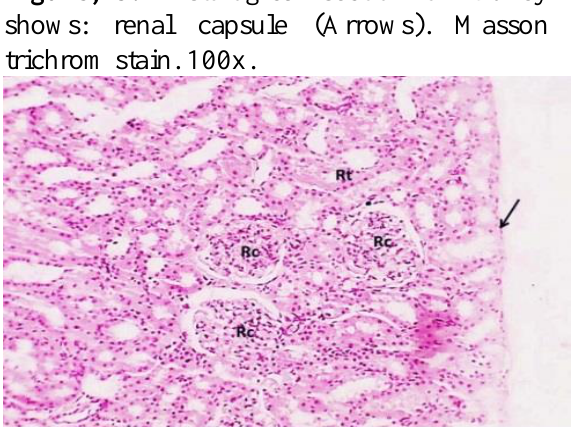
Figure, 6: Histological section of renal cortex shows; renal corpuscles (Rc) renal tubules (Rt). H&E stain.100x.